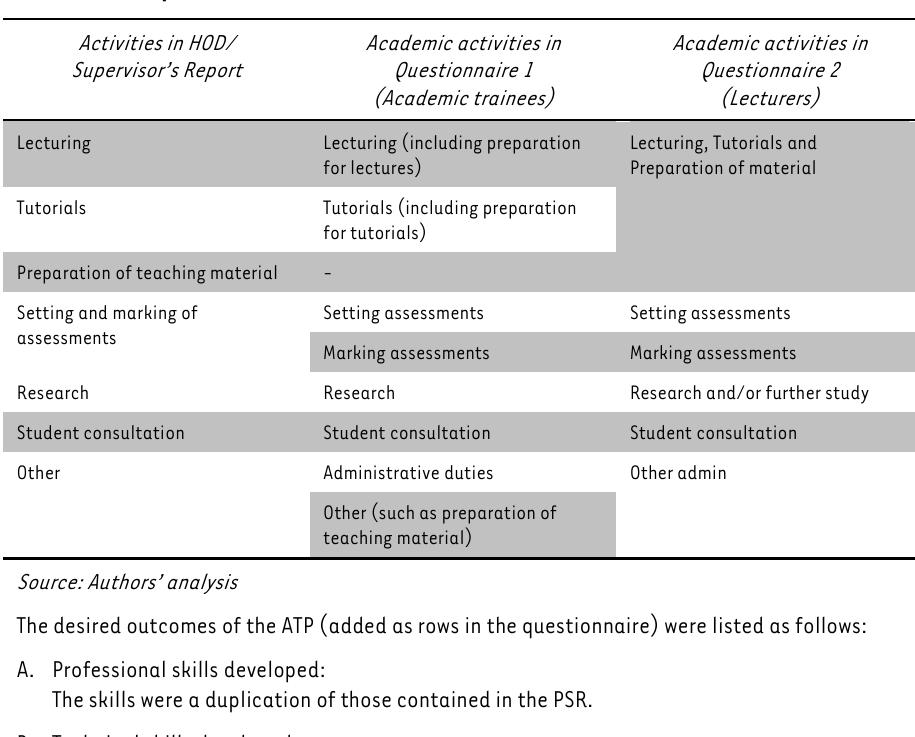
Comparison of academic